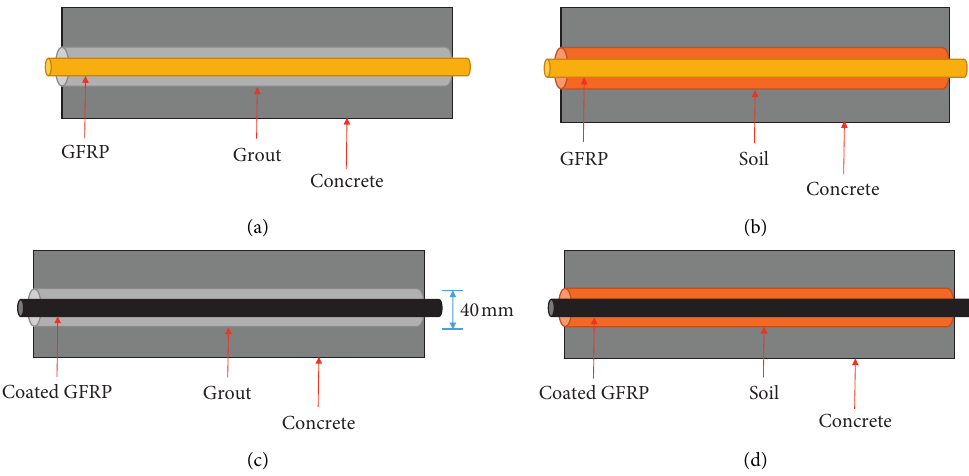
Figure 14: Four different types of GFRP rock bolt sensors: (a) fixed with cement grout without coating; (b) fixed with soil without coating; (c) fixed with cement grout with coating; (d) fixed with soil with coating.